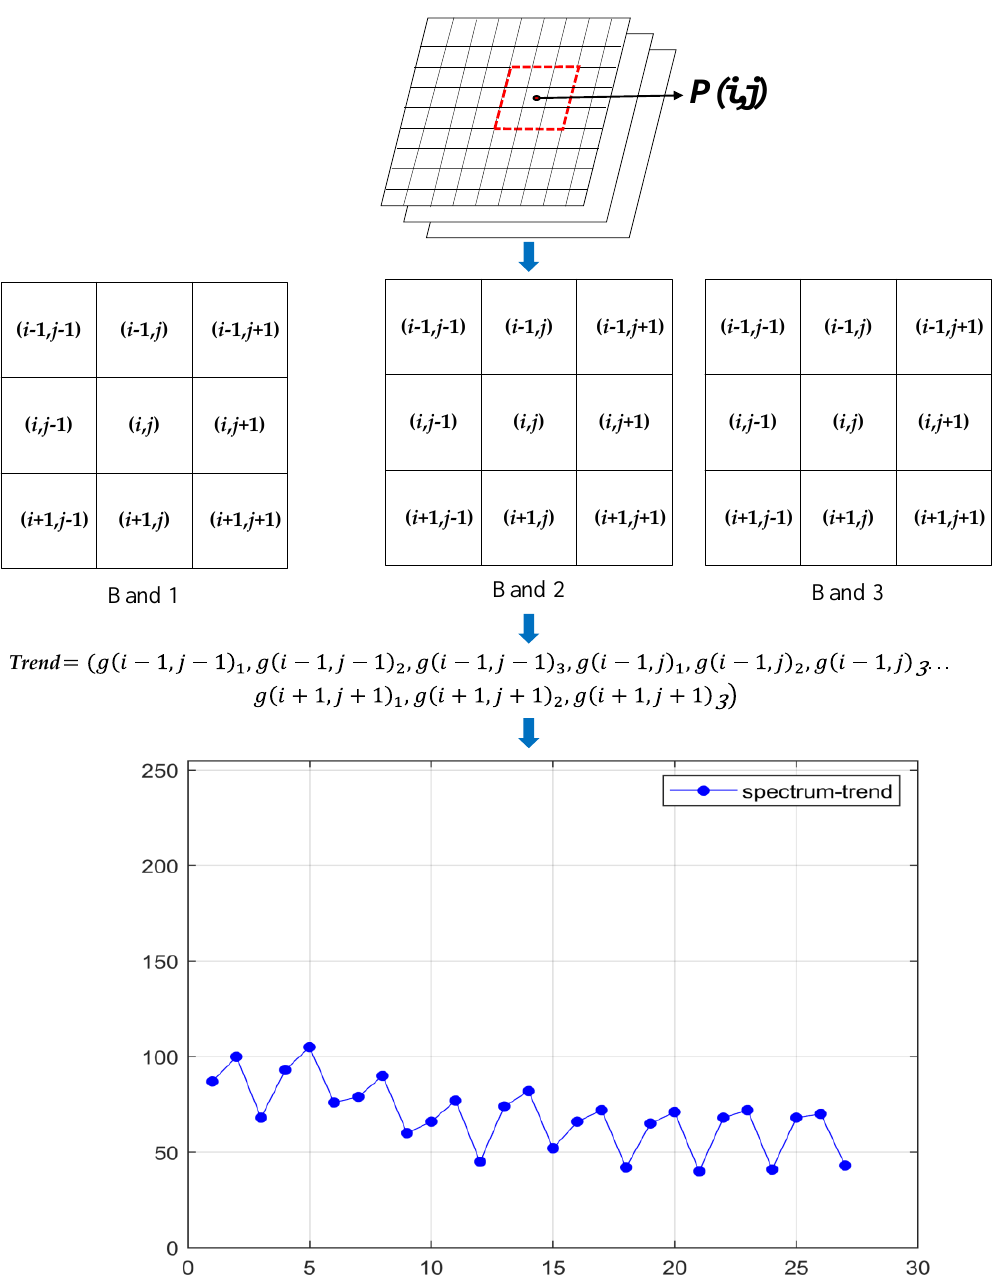
Figure 2. The illustration of produce of spectrum-trend graph ( n = 3, B = 3).